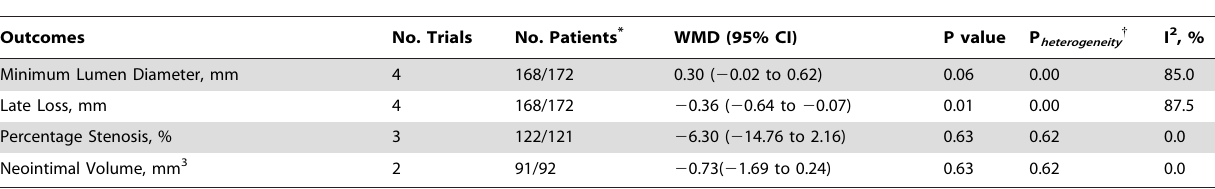
Table 4. Clinical Endpoints: Continuous